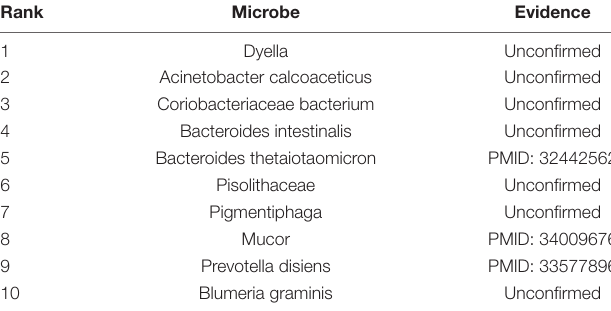
TABLE 4 | Top 10 candidate microbes related to